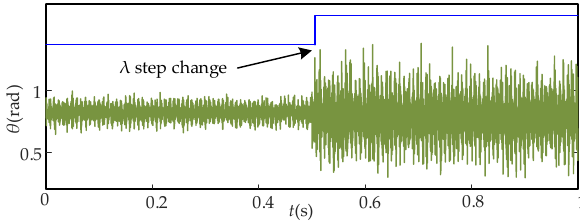
Figure 14. Initial phase response waveform with increased noise ratio.